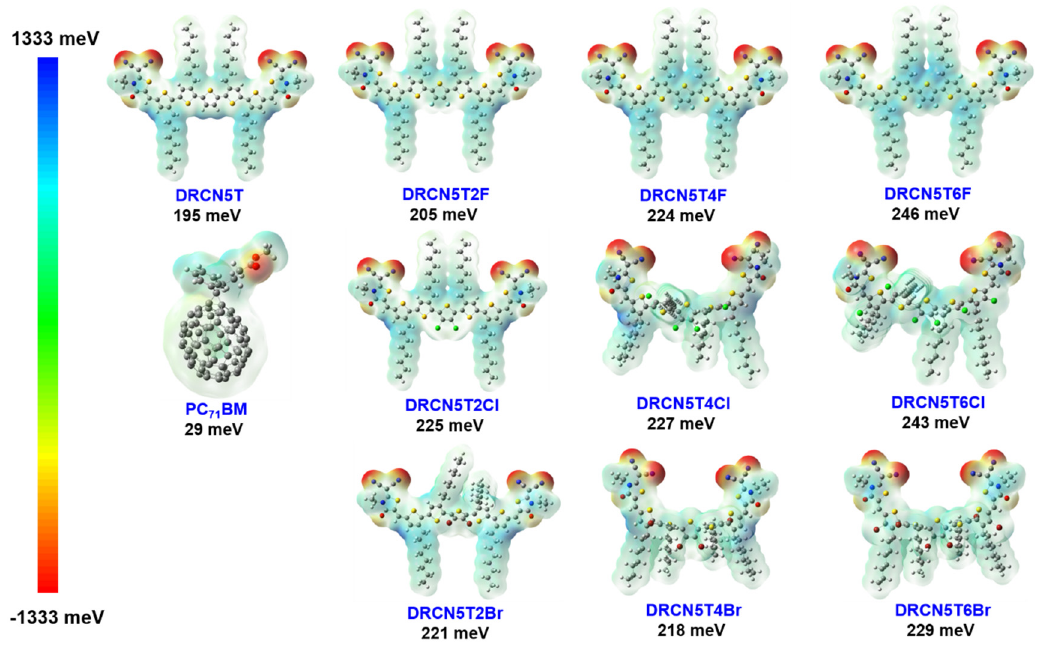
Figure 9. Averaged ESP of DRCN5T, DRCN5T2F, DRCN5T4F, DRCN5T6F, DRCN5T2Cl, DRCN5T4Cl, DRCN5T6Cl, DRCN5T2Br, DRCN5T4Br, DRCN5T6Br, and PC 71 BM calculated on B3LYP/6 − 31G(d) level.